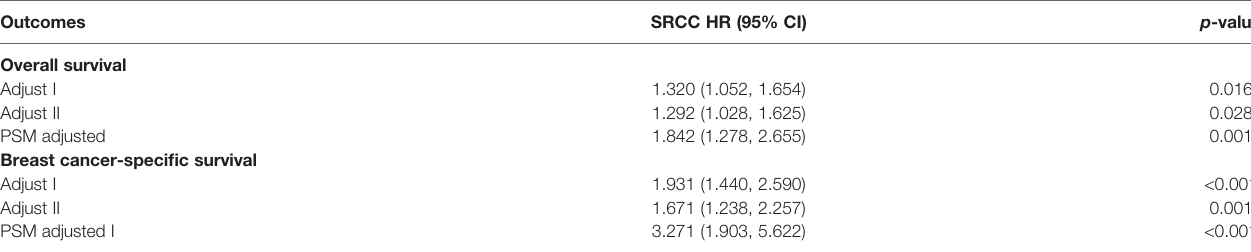
TABLE 3 | Prognostic factors for overall survival (OS) and breast cancer-caused speci fi c survival (BCSS) by multivariable Cox proportional hazard model. Outcomes Overall survival Adjust I